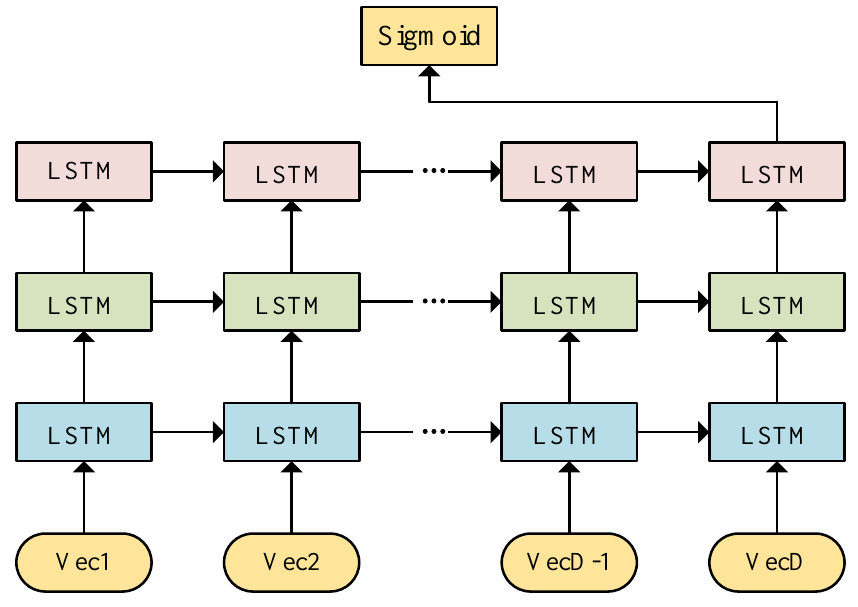
Figure 6. Structure of a stacked LSTM